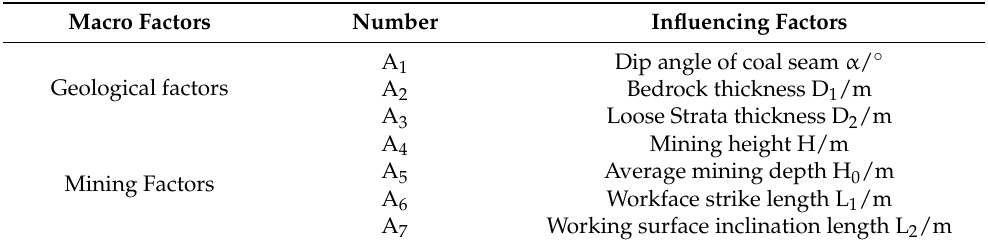
Table 1. Influence factors of surface subsidence caused by coal mining in Lu’an mining area. Macro Factors Number Influencing Factors A 1 Dip angle of coal seam α / ◦ Geological factors A 2 Bedrock thickness D 1 /m A 3 Loose Strata thickness D 2 /m A 4 Mining height H/m A 5 Average mining depth H 0 /m Mining Factors A 6 Workface strike length L 1 /m A 7 Working surface inclination length L 2